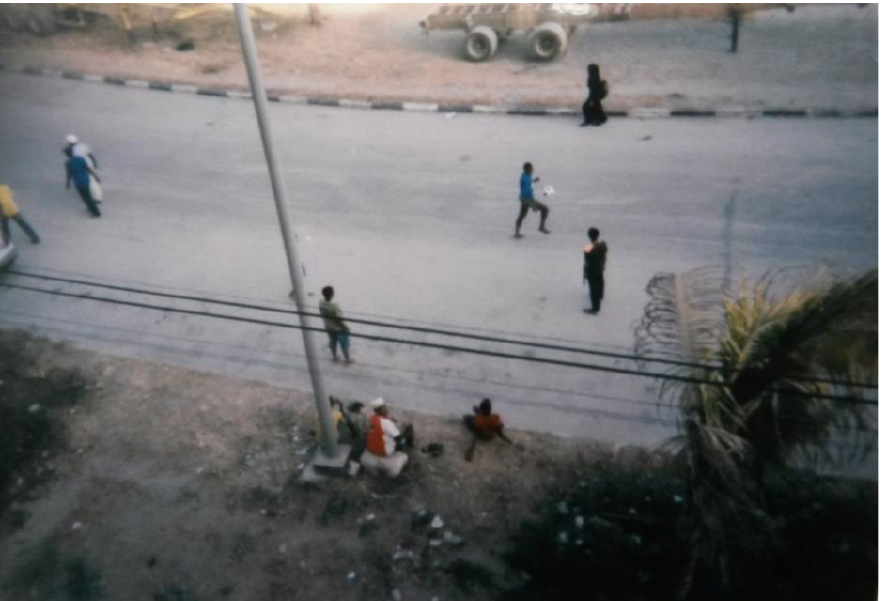
Figure 2. ‘Children love to play outside safely [ na usalama ] with their friends, like playing football’. (Subira, 13 years